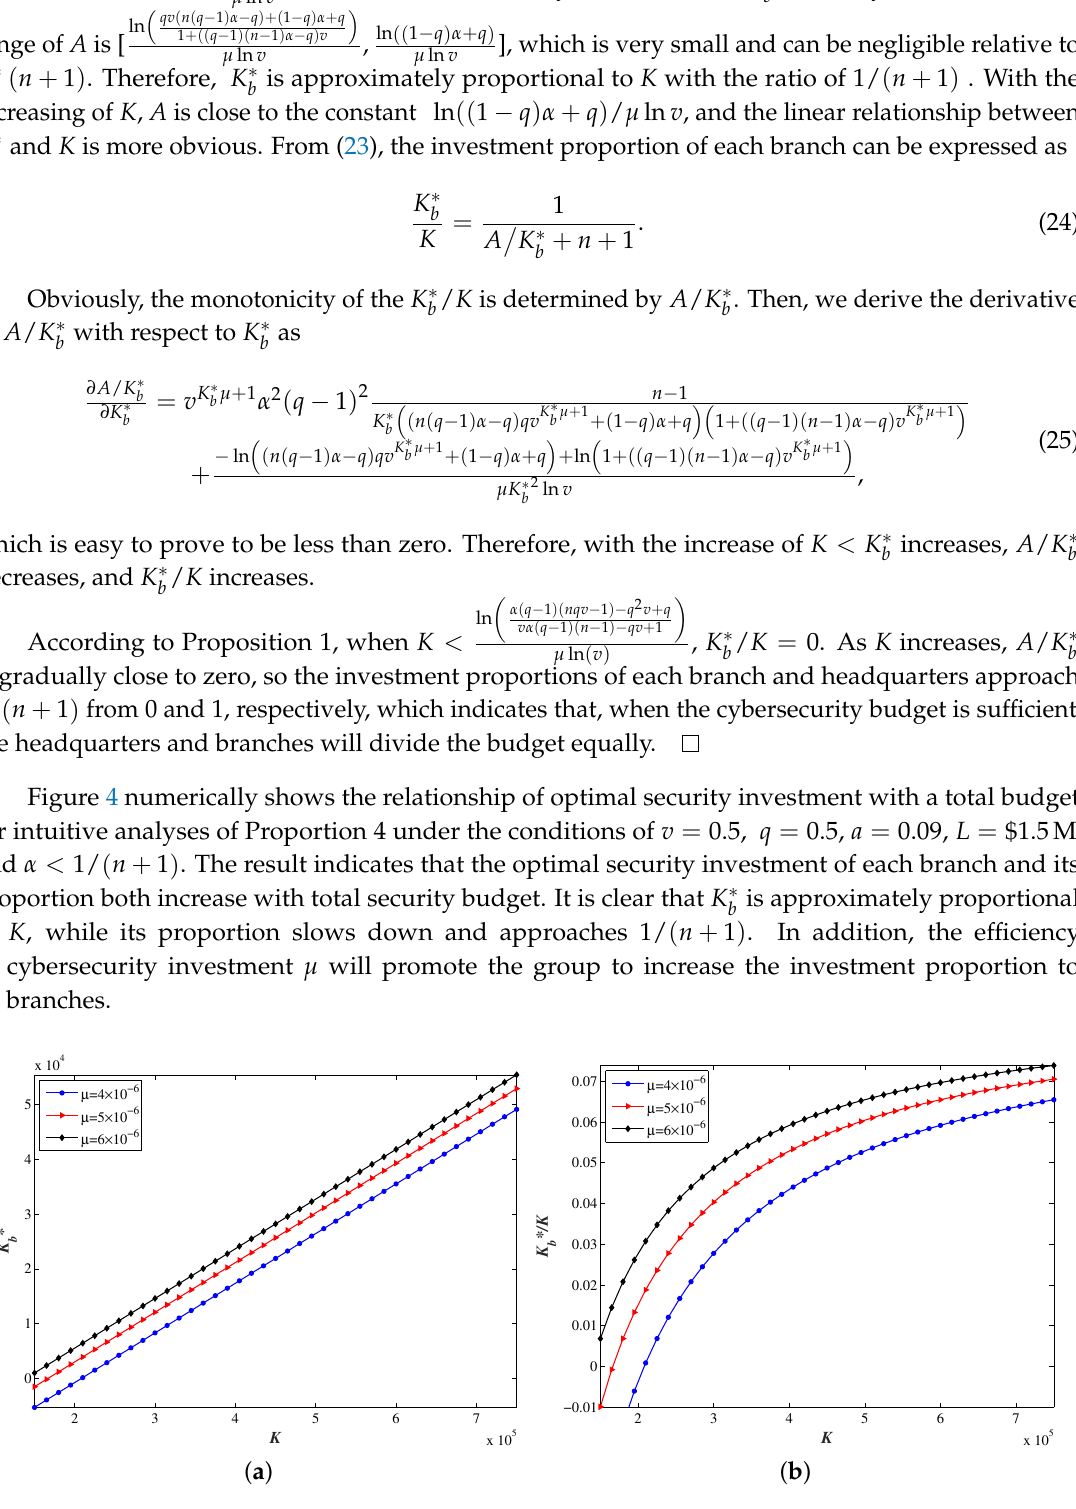
Figure 4. Optimal security investment and its allocation with a security investment